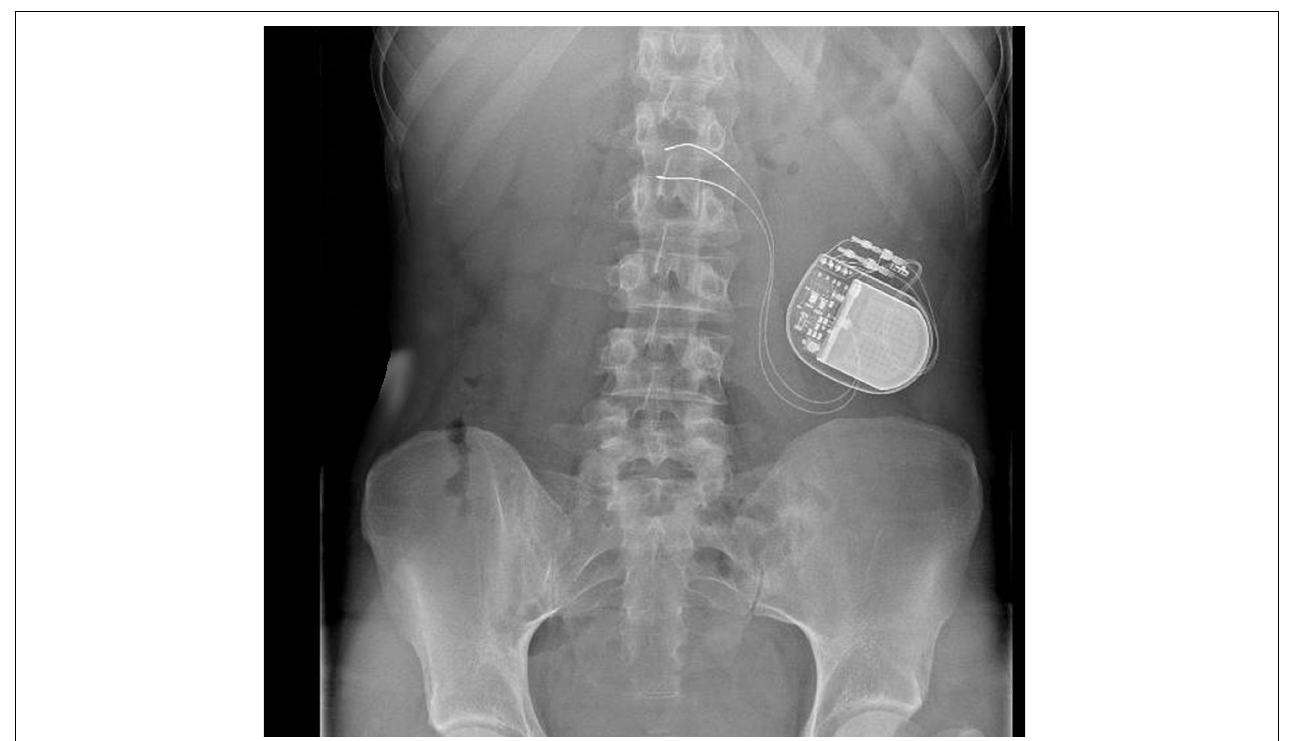
FIGURE 1 | Radio of gastric electrical stimulator after